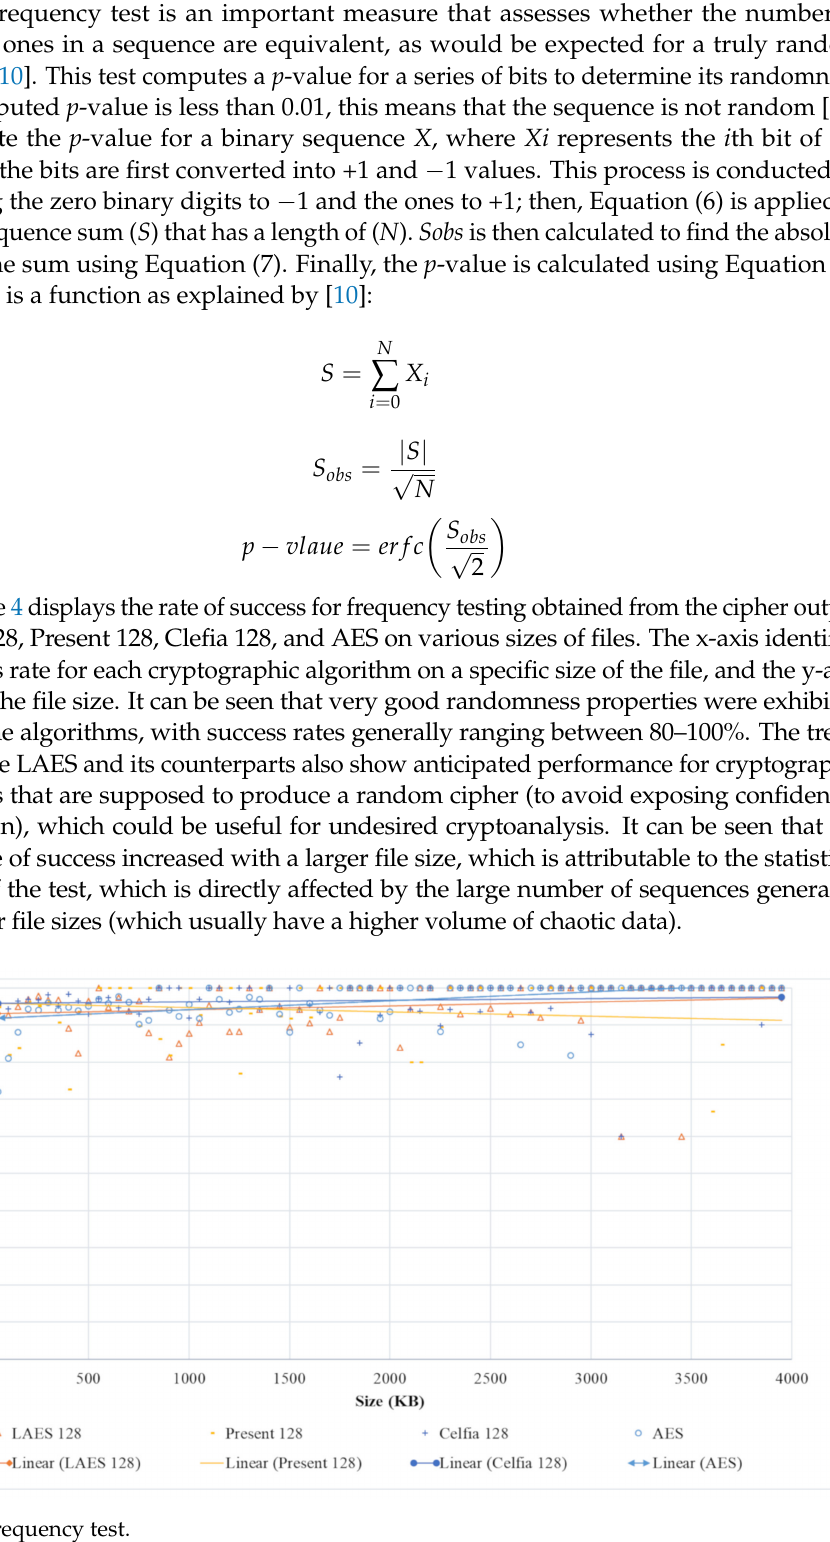
Figure 4. Frequency